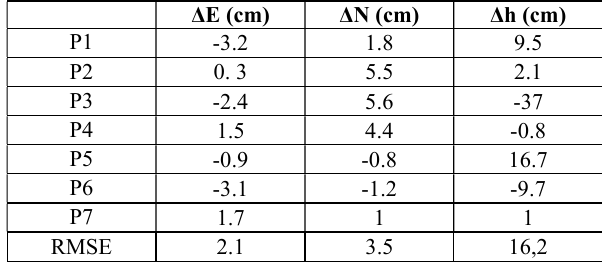
Table 1 . Differences between Topcon and u-blox coordinates.